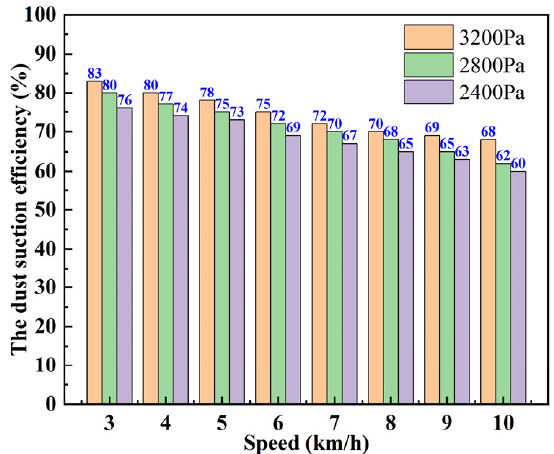
Figure 15. Vacuum efficiency at different driving speeds and negative pressures.